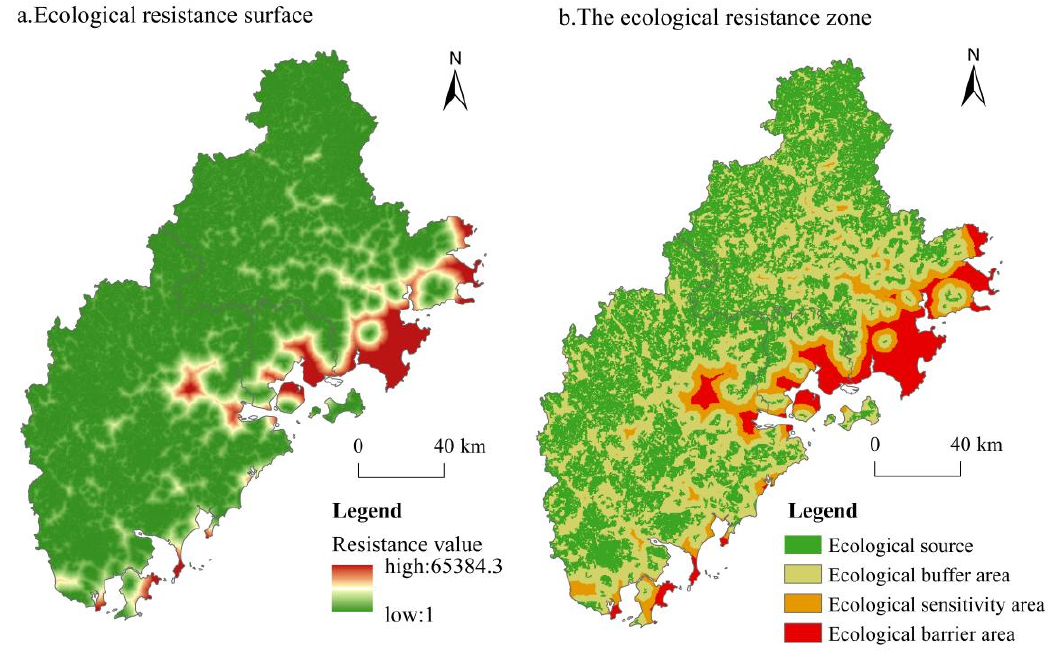
Figure 4. Distribution of minimum cumulative resistance difference and ecological resistance zones.